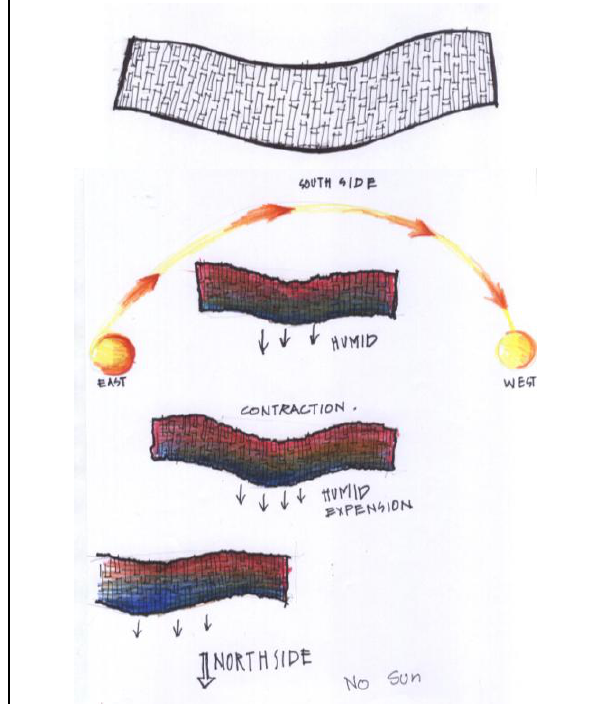
Figure 6: Exaggerated deformation pattern for